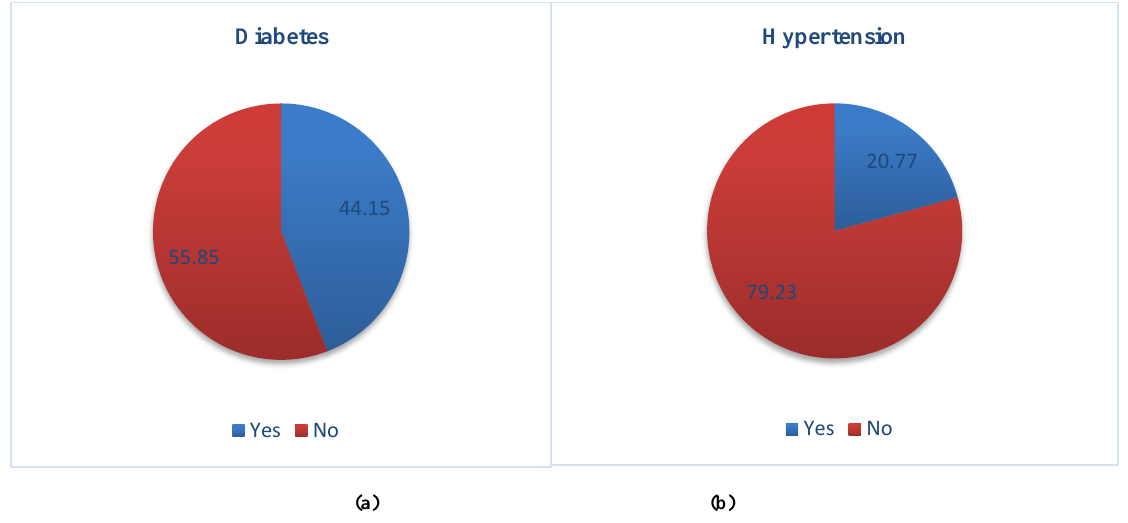
Fig. 2. Distribution of study participants with etiology-wise (a) Diabetes, (b)